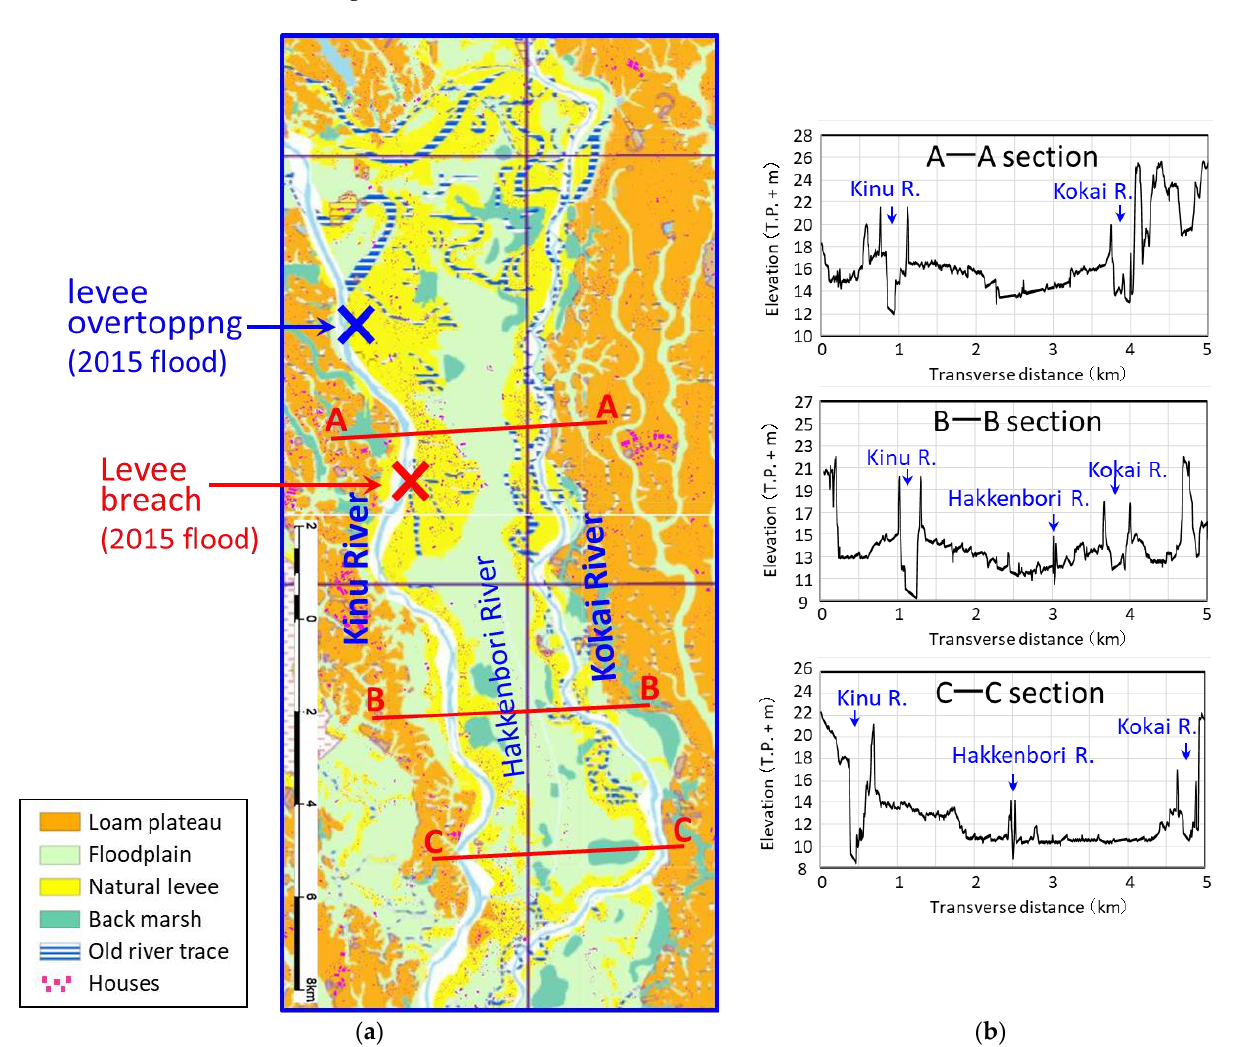
Figure 8. Closed floodplain damaged by flooding in 2015; ( a ) enlarged view of upstream floodplain indicated in Figure 7 and ( b ) cross sections seen from downstream of three transverse lines in ( a ).